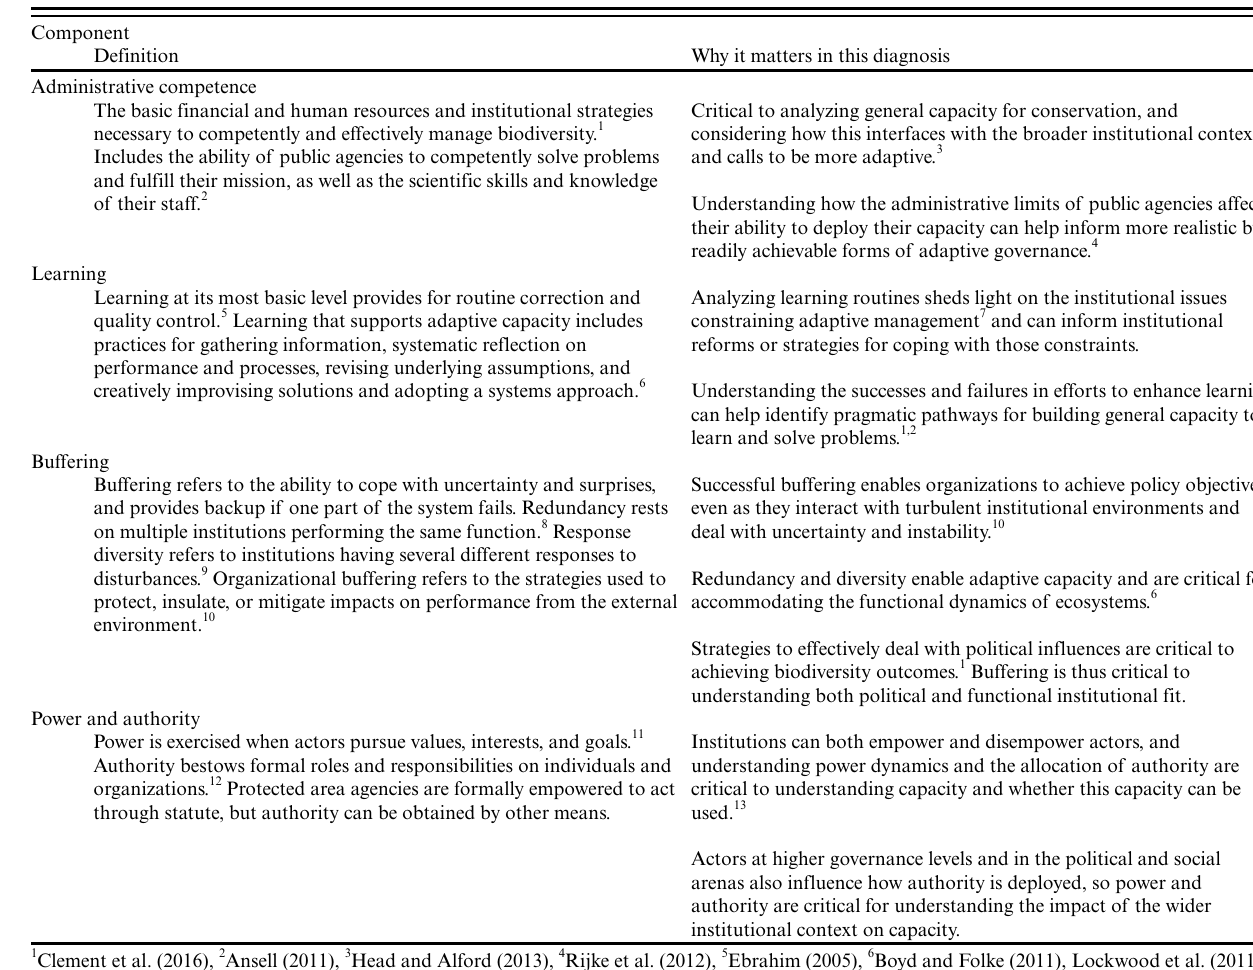
Table 2 . Summary of framework components salient to this